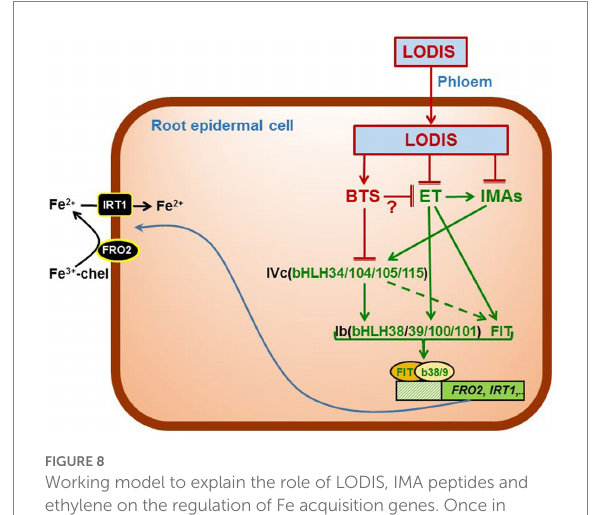
FIGURE 8 Working model to explain the role of LODIS, IMA peptides and ethylene on the regulation of Fe acquisition genes. Once in shoots, some Fe (either as free ions or in chelated form) can enter the phloem through the OPT3 transporter and move back to roots bound to a chelating agent (forming LODIS). In roots, LODIS could negatively affect IMA expression and ethylene synthesis and signaling, either directly or through BTS. Ethylene can affect IMA expression as well as the expression of FIT and Ib-bHLH expression. Both IMAs and BTS interact to regulate IVc- bHLH activity, which influence Ib-bHLHs and FIT and, consequently, Fe acquisition genes. ET (ethylene), IMAs (IMA peptides). ( → : promotion; ⊥ :